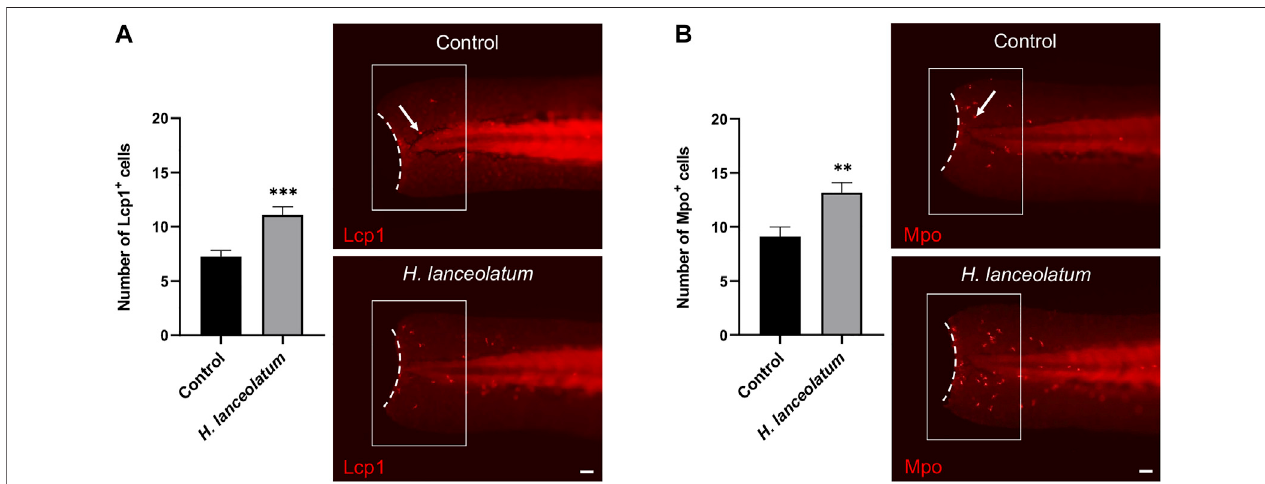
FIGURE 7 | H. lanceolatum aqueous extract improves the recruitment ofneutrophils and macrophages after tail injury. Number of (A) Lcp1-positive (macrophage) and (B) Mpo-positive(neutrophils)cells(arrows)attheinjurysite(whitebox)andrepresentativepicturesoftailamputationsof3-dpfeleutheroembryos,incubatedwithE3 medium (Control) or H. lanceolatum aqueous extract at 0.3125 g/L ( H. lanceolatum ) for 6 h. Dotted lines represent the tail amputation level. Results are expressed as means ± SEM ( n = 34/group from 3 independent experiments). ** p < 0.01, *** p < 0.001 (Student t-test). Bar = 40